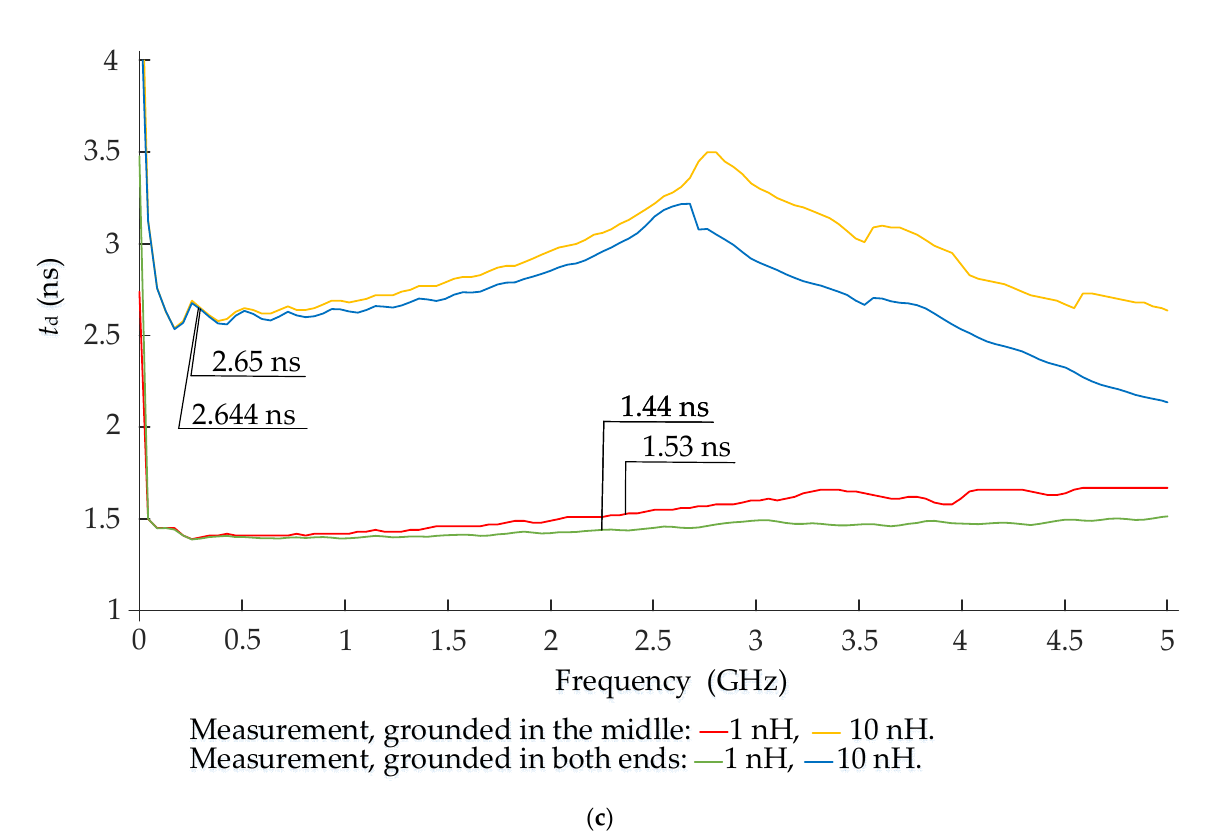
Figure 7. Results of the physical experiment of the ( a ) S 21 , ( b ) S 11 , and ( c ) t d characteristics of the hybrid meander structure when the lumped inductive elements have values of 1 and 10 nH and the additional shields are grounded in the middle or in both ends of the additional shields.